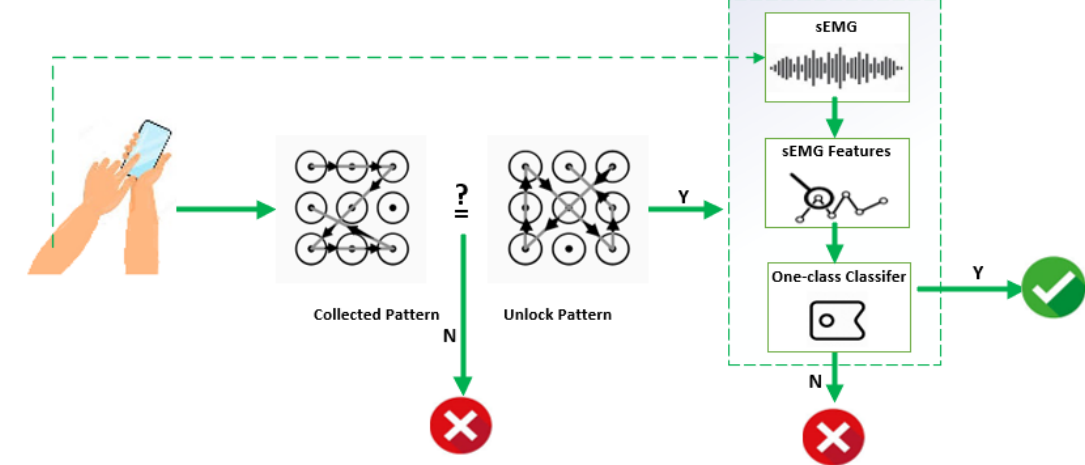
Figure 2. The workflow of the proposed two-factor screen unlock